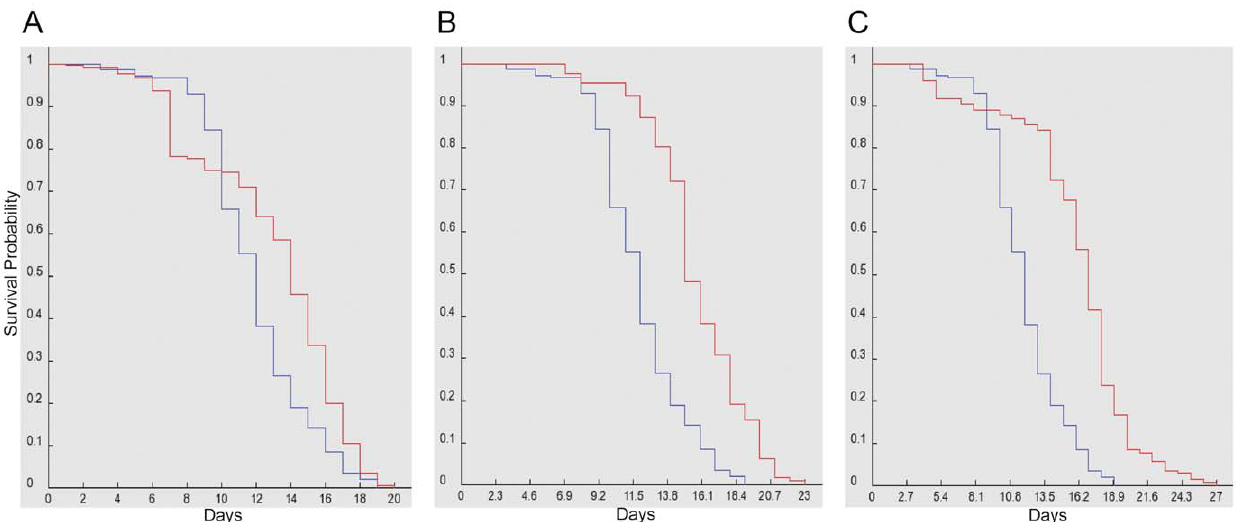
Figure 9. GGA mutant flies are hypersensitive to amino acid starvation. Blue lines represent: GGA D males (n=212 and median survival time 11.30 days) Red lines represent a. yw males (n=202, P-value , 0.0001 and median survival time 13.65 days) b. yw GGA D ; P{GGA + } A2 males (n=131, P- value , 0.0001 and median survival time 14.92 days) c. yw GGA D ; P{GGA + } E2 males (n=144, P-value , 0.0001 and median survival time 16.4 days).